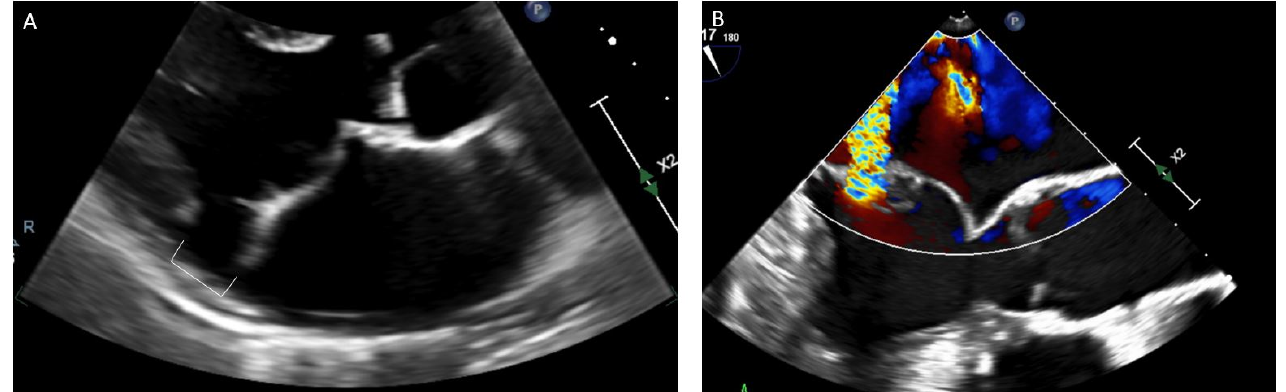
Figure 3. Echocardiographic findings of arrhythmic mitral valve prolapse and mitral annular dis- junction. ( A ) Transthoracic echocardiography view of bileaflet prolapse seen with mitral annular disjunction (bracket) in the parasternal long axis view. ( B ) Transesophageal echocardiography view of mitral valve prolapse with color Doppler showing mitral regurgitation in a mid-esophageal long axis view.